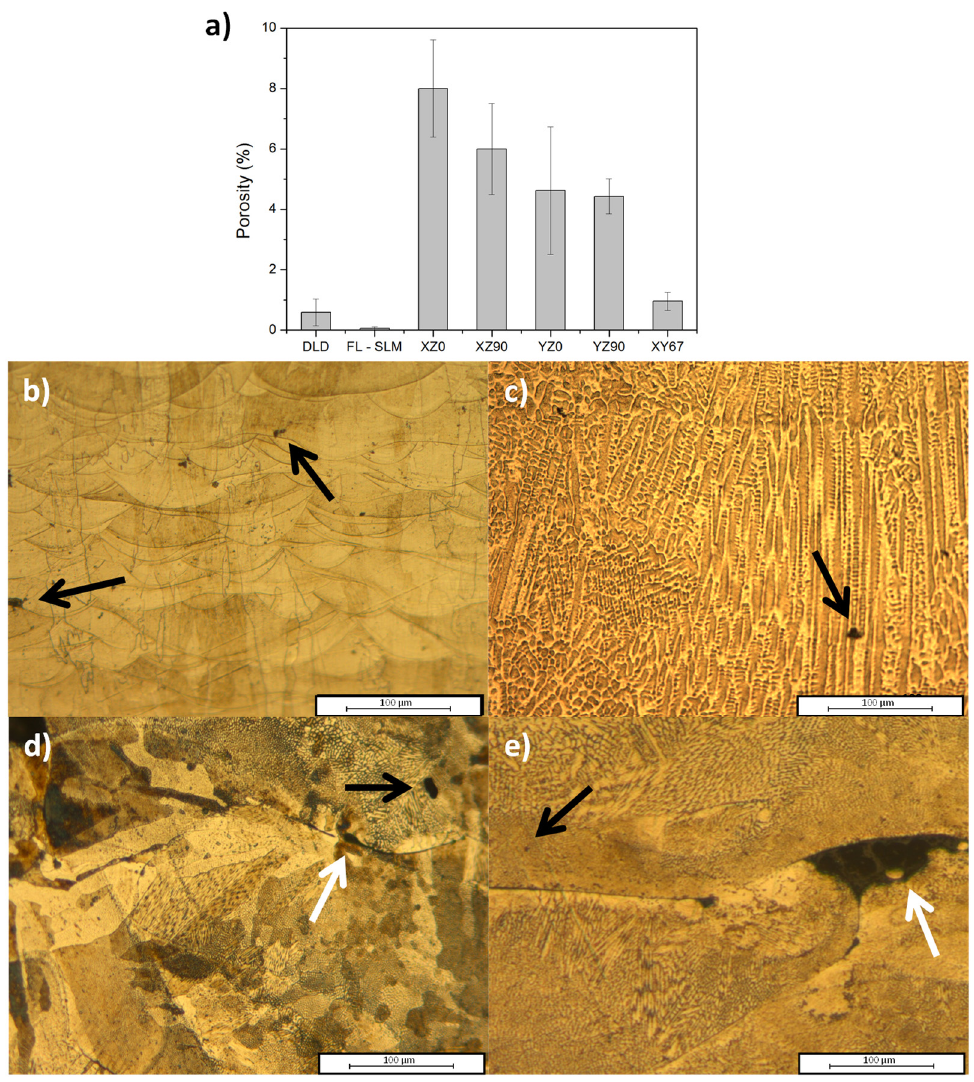
Figure 10. ( a ) Porosity of the samples manufactured. Pores (black arrow) and lack of fusion (white arrow) in ( b ) DLD; ( c ) FL–SLM; ( d ) CO 2 laser XZ90 sample; ( e ) XY67 sample. arrow) in ( b ) DLD; ( c ) FL–SLM; ( d ) CO 2 laser XZ90 sample; ( e ) XY67